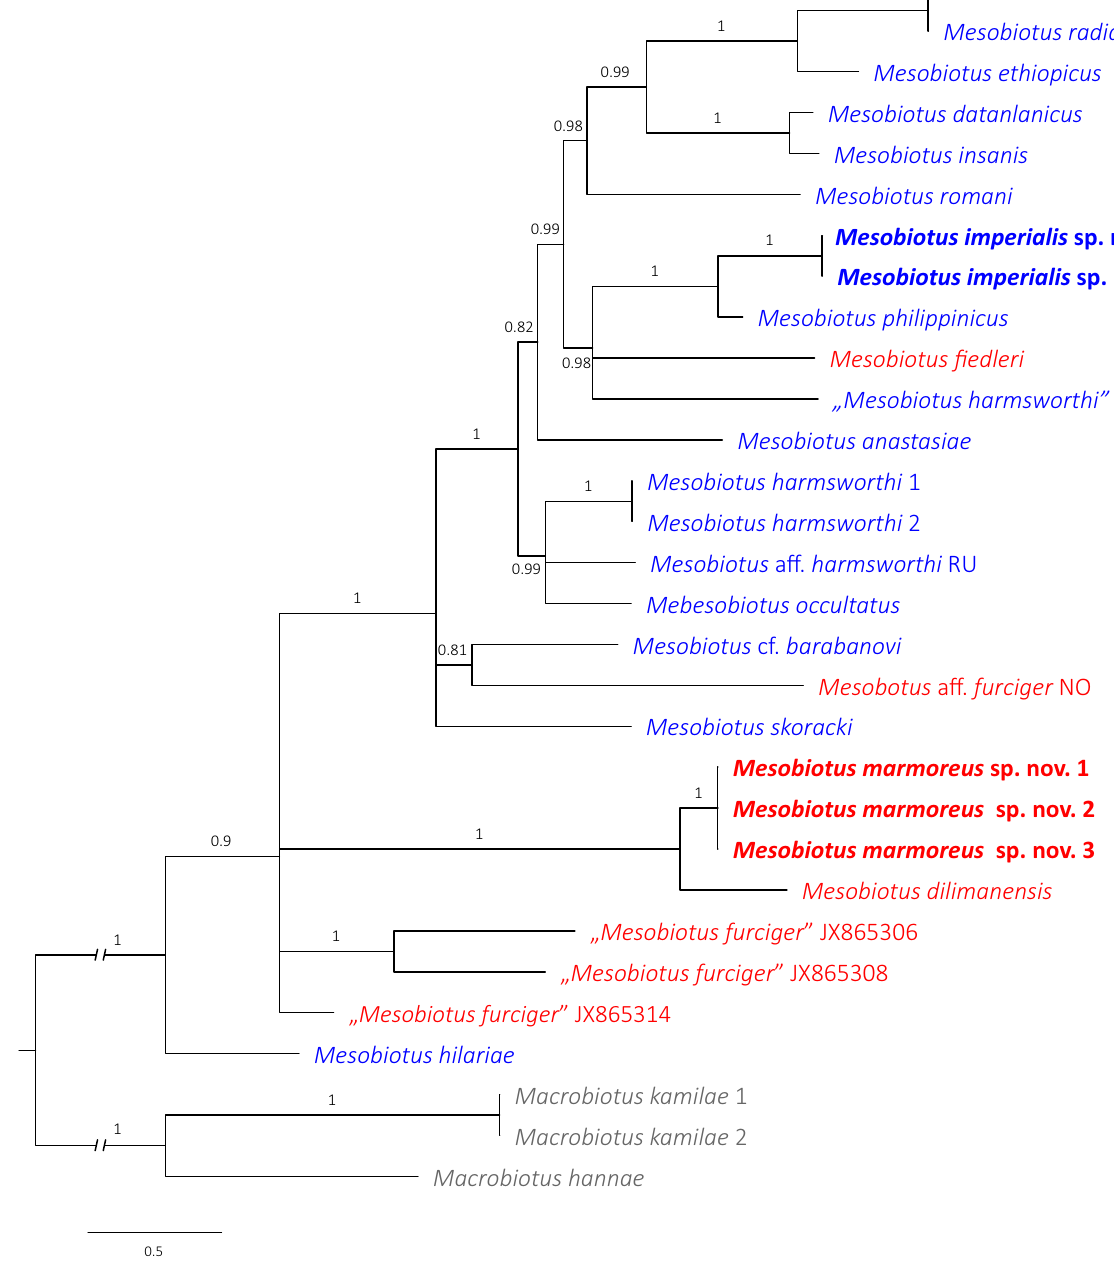
Figure 12. The Bayesian Inference (BI) phylogeny constructed from concatenated sequences (18S rRNA + 28S rRNA + ITS-2 + COI) of the genus Mesobiotus . Numbers at nodes indicate Bayesian posterior probability; nodes with values below 0.80 have been collapsed. Taxa newly sequenced in this study are marked with bolded font. Taxa of the M. harmsworthi and M. furciger complex are indicated by blue and red font, respectively. Outgroup is indicated by grey font. Quotation marks indicate misidentified Mesobiotus species or species with uncertain species identification. Scale bar represents substitutions per